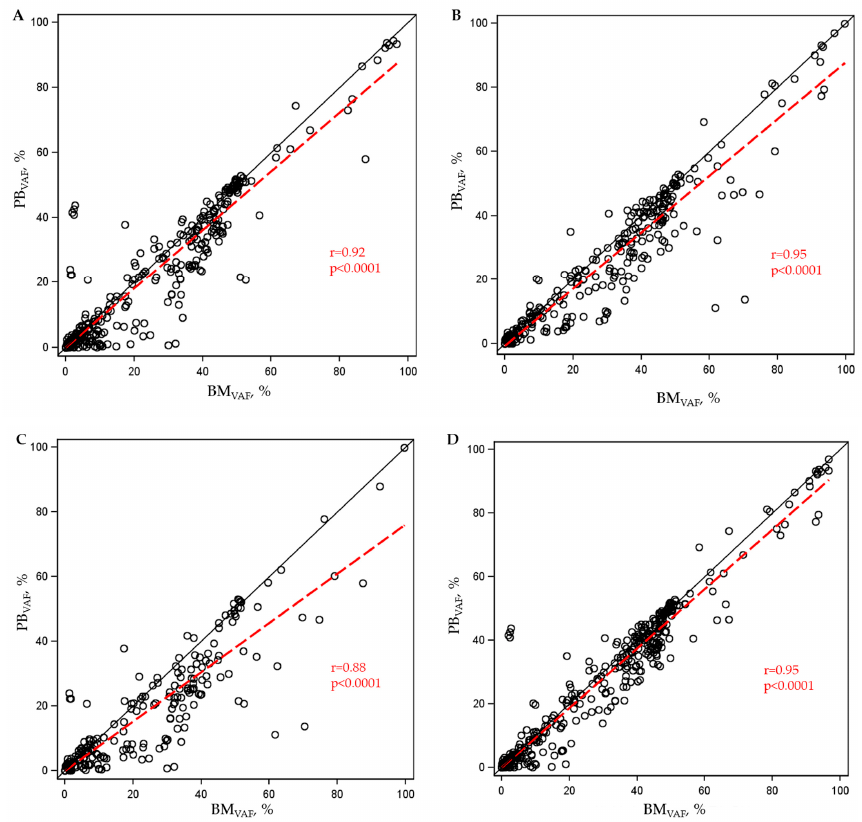
Figure 4. Sca tt erplot of the variant allele frequency (VAF) of the mutated genes in bone marrow and peripheral blood for patient samples with the following peripheral blood parameters on the day of bone marrow sampling. ( A ) Peripheral blast percentage = 0% (n = 165). ( B ) Peripheral blast percent- age ≥ 1% (n = 74). 1 ( C ) Absolute neutrophil count < 1.0 G/L (n = 66). ( D ) Absolute neutrophil count ≥ 1.0 G/L (n = 174). The black line is the bisecting line showing a perfect linear regression with slope = 1 and intercept = 0. The red dashed line is the regression line, indicating the correlation between BM VAF and PB VAF of each paired sample. ( 1 The peripheral blood blast percentage was missing for one patient).